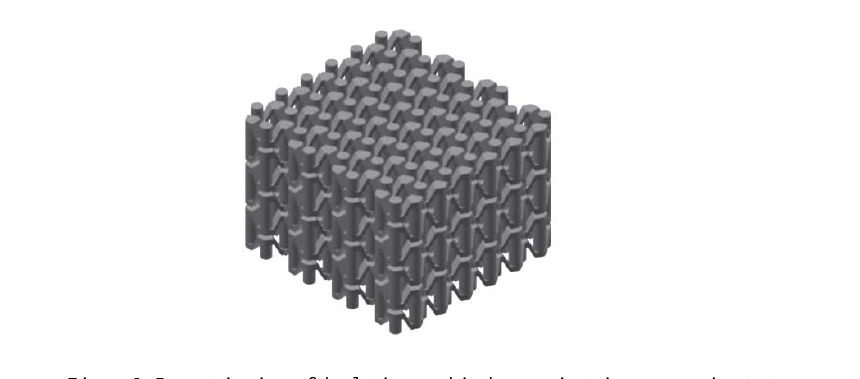
Figure 2: Isometric view of the lattice used in the quasi-static compression test.